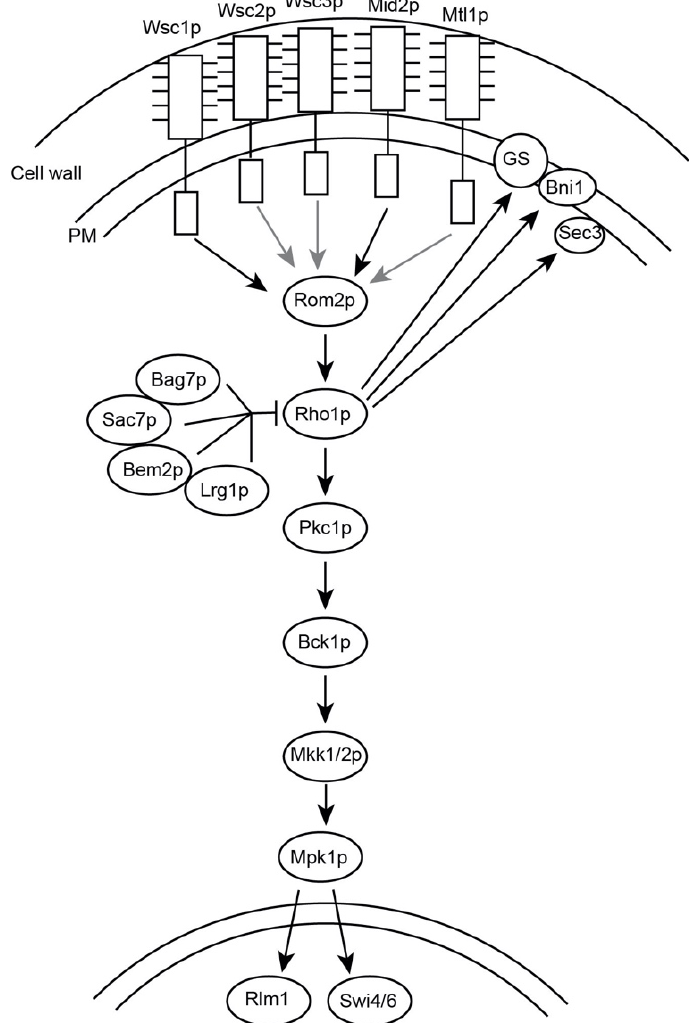
Figure 1. Overview of the Cell Wall Integrity Pathway. The CWI transmits signals through five transmembrane proteins, Wsc1p, Wsc2, Wsc3, Mid2p and Mtl1p. These proteins are anchored in the plasma membrane (PM) and extend into the cell wall. The transmembrane proteins signal through Rom2p to activate Rho1p. Rho1p is responsible for the activation of the 1,3- β -glucan synthase (GS), a formin (Bni1p), Sec3p, and Pkc1p. Rho1p is acted upon by four Rho-GAPs, Sac7p, Bag7, Lrg1, and Bem2p. The CWI pathway is a MAP kinase cascade that culminates in the phosphorylation of Mpk1p, which activates transcription factors Rlm1p and SBF (Swi4p/Swi6p) to activate genes involved in cell cycle regulation and cell wall biogenesis. (Adapted from Levin, 2005 and Levin, 2011). Rho1p cycles between GTP and GDP bound states, which are regulated by a set of GTPase-activating proteins (GAPs) and GEFs. Rom1p and Rom2p are the activating GEFs that respond to signals from the transmembrane proteins in the CWI pathway [17]. Four Rho-GAPs act on Rho1p: Bag7p, Sac7p, Lrg1p, and Bem2p [1,19–23] (Figure 1). The